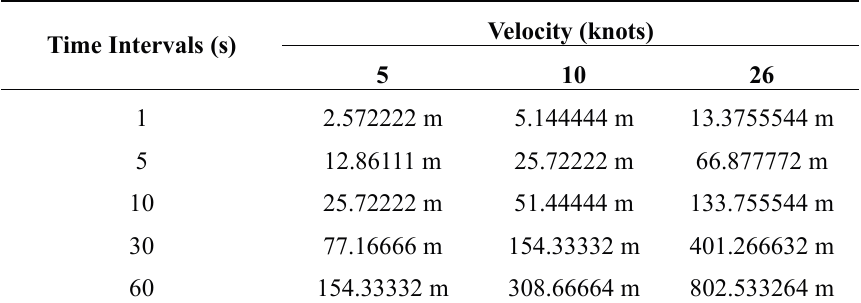
Table 4. Voyage with different time intervals.